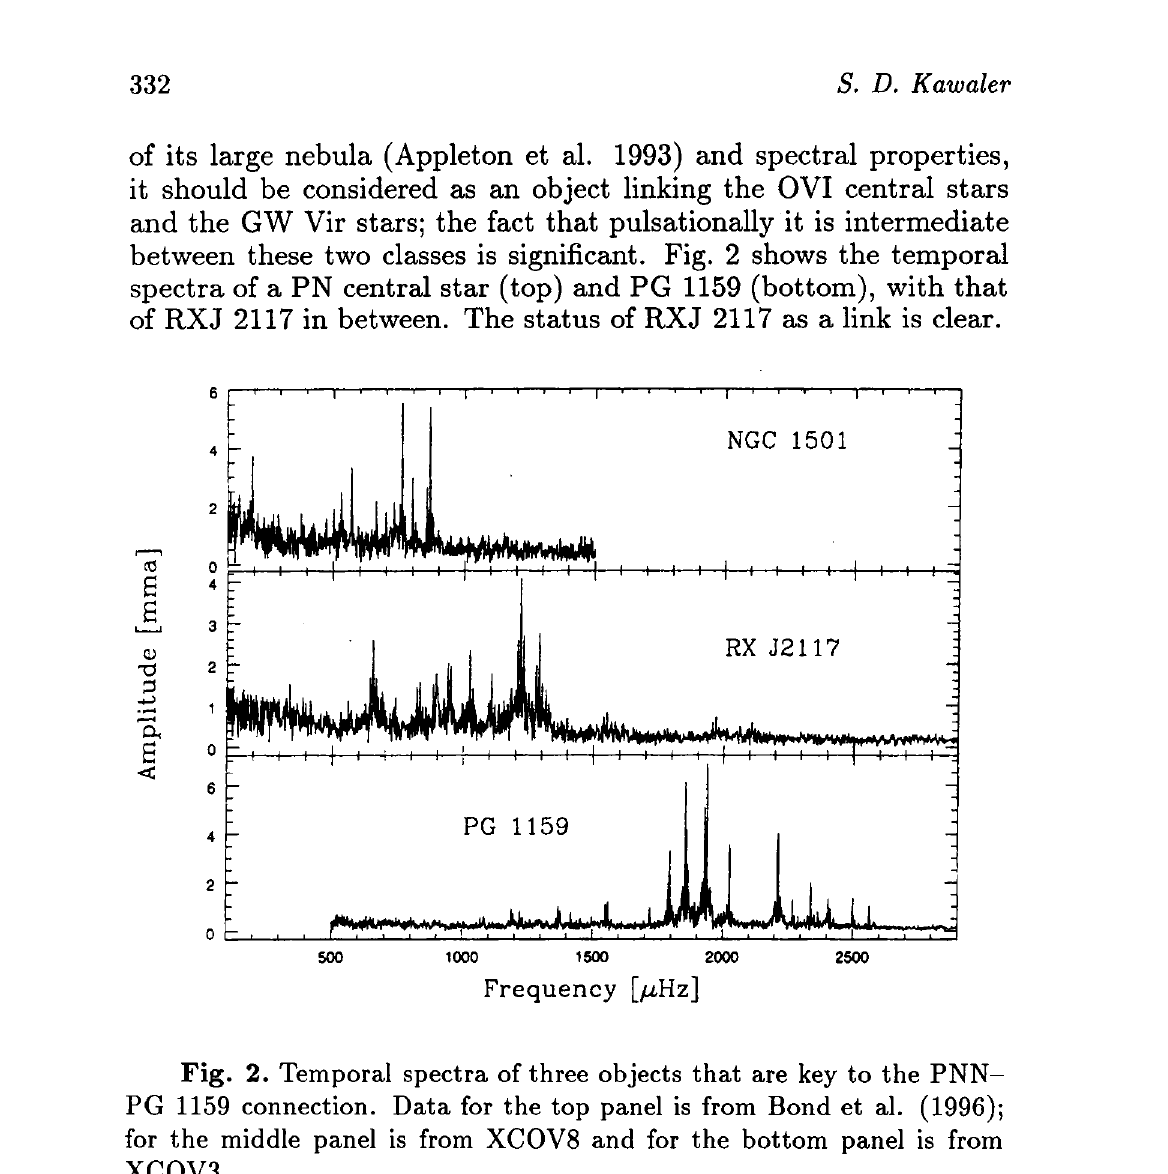
Fig. 2. Temporal spectra of three objects that are key to the PNN- PG 1159 connection. Data for the top panel is from Bond et al. (1996); for the middle panel is from XC0V8 and for the bottom panel is from